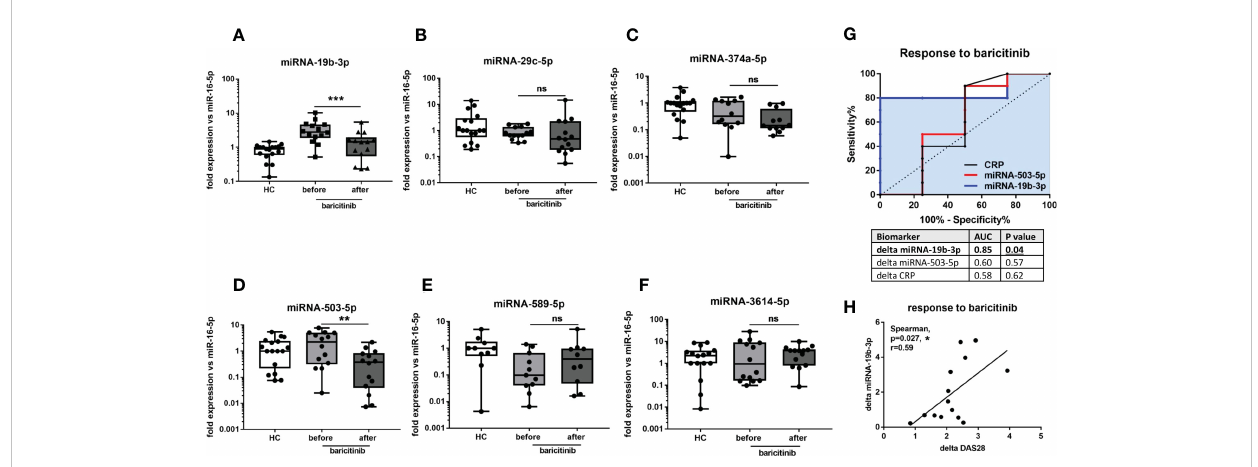
FIGURE 5 The levels of circulating miRNA in HC and RA patients upon baricitinib therapy. The levels of miRNA-19b-3p (A) , miRNA-29c-5p (B) , miRNA-374a-5p (C) , miRNA-503-5p (D) , miRNA-589-5p (E) , miRNA-3614-5p (F) before and 3 months after baricitinib treatment in RA patients compared to HC. ROC analysis of changes/delta in miRNA-19b-3p and miRNA-503-5p expression and CRP level upon JAKi therapy (G) . Correlation analysis between the expression of delta miRNA-19b-3p and delta DAS28 in baricitinib-treated RA patients (H) . P-values were expressed as follows: ns for not signi fi cant; 0.05 > P > 0.01 as *; 0.01 > P > 0.001 as **; P < 0.001 as ***, P <0.0001 as